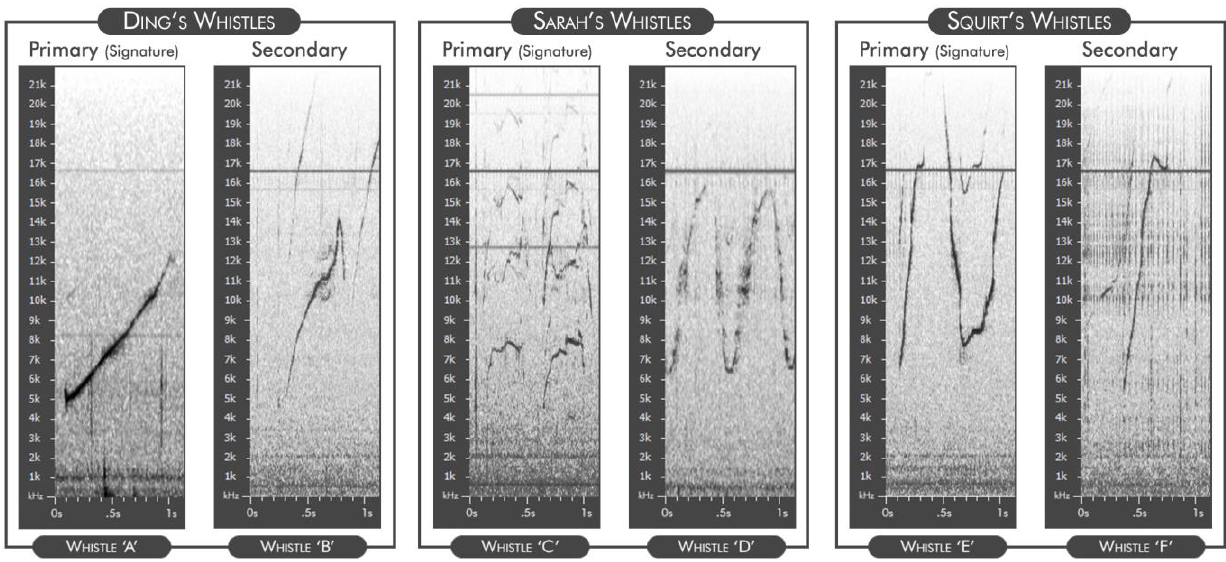
Figure 3. Spectrograms of six distinct whistle contours recorded during all call calf retrievals. Each mother produced only two contours to call their respective calves, identified as Signature Whistle (Ding: A, Sarah: C, Squirt: E) and Secondary Whistle (Ding: B, Sarah: D, Squirt: F). Sound sampling at 46 kHz, Nyquist frequency cut off at 23 kHz, with a consistent apparatus sound artifact at ~17 kHz.